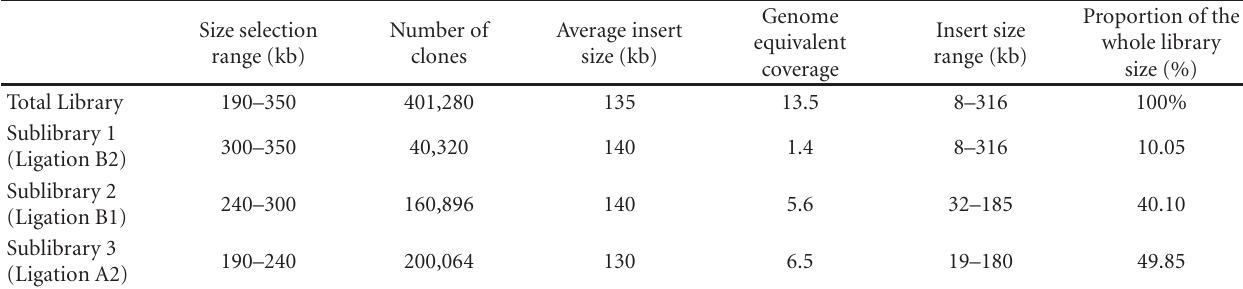
Table 1: Composition of the Camellia sinensis tea BAC library,